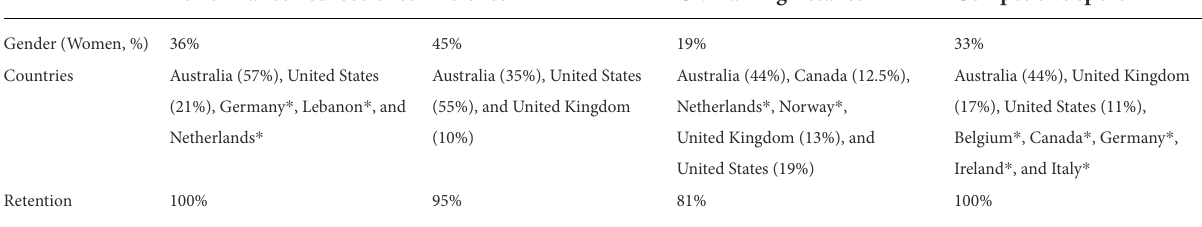
TABLE 2 Characteristics across the panels. Performance neuroscience